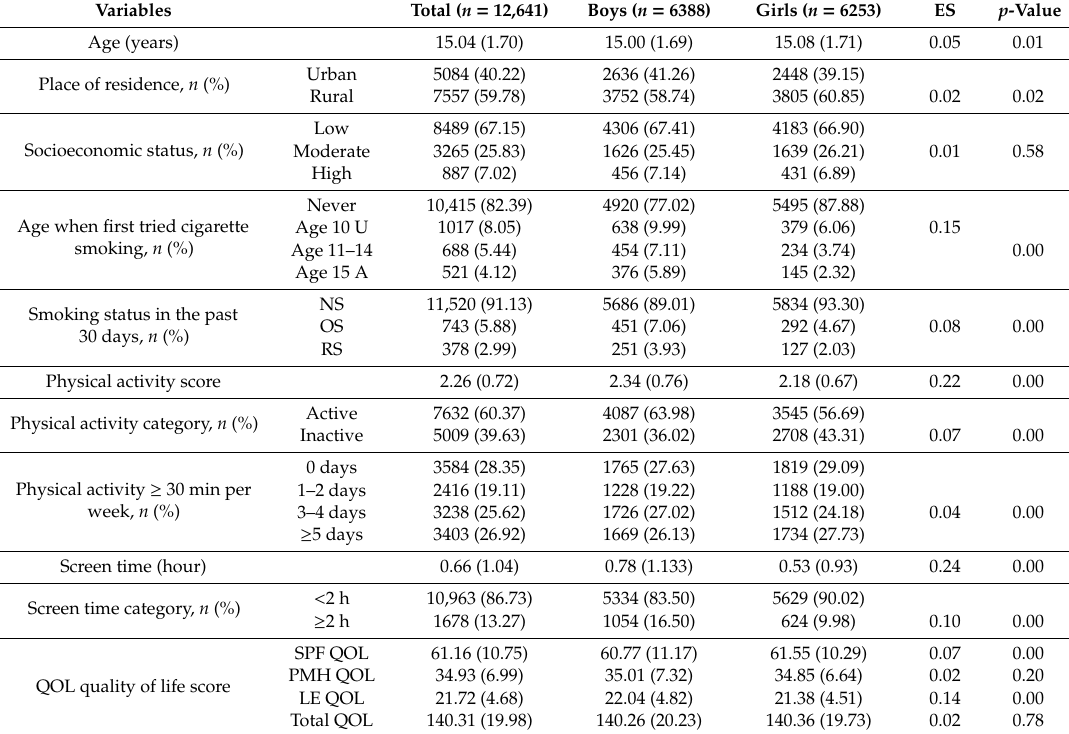
Table 1. General characteristics of participants according to gender among adolescents.